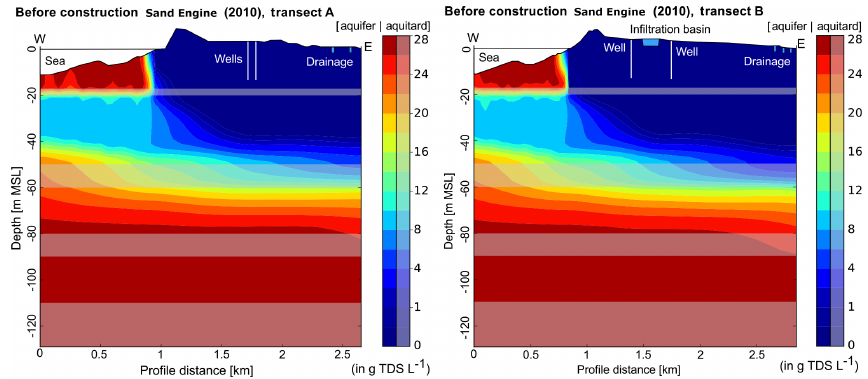
Figure 11. Transects with the simulated groundwater salinity (in g TDS L − 1 ) in 2010 (pre-development Sand Engine), for transect A and B (as shown in Figs. 2 and 3).